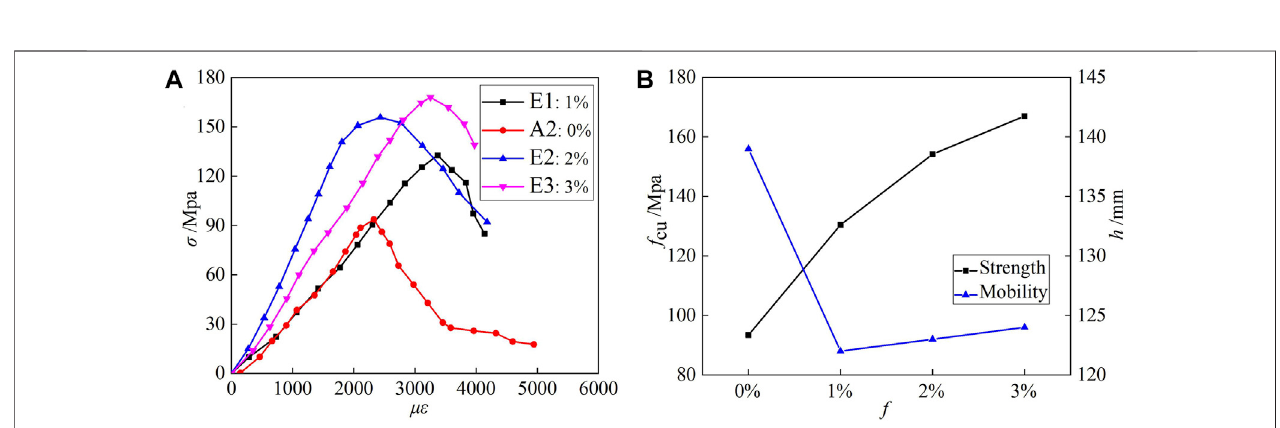
FIGURE8| Thein fl uenceofdifferentratiosofquartzsandtocementonRPCmechanicalproperties. (A) Stress-straincurvesofRPCspecimenswithdifferentratios of quartz sand to cement. (B) Ultimate compressive strength and mixture fl uidity of RPC with different ratios of quartz sand to cement.